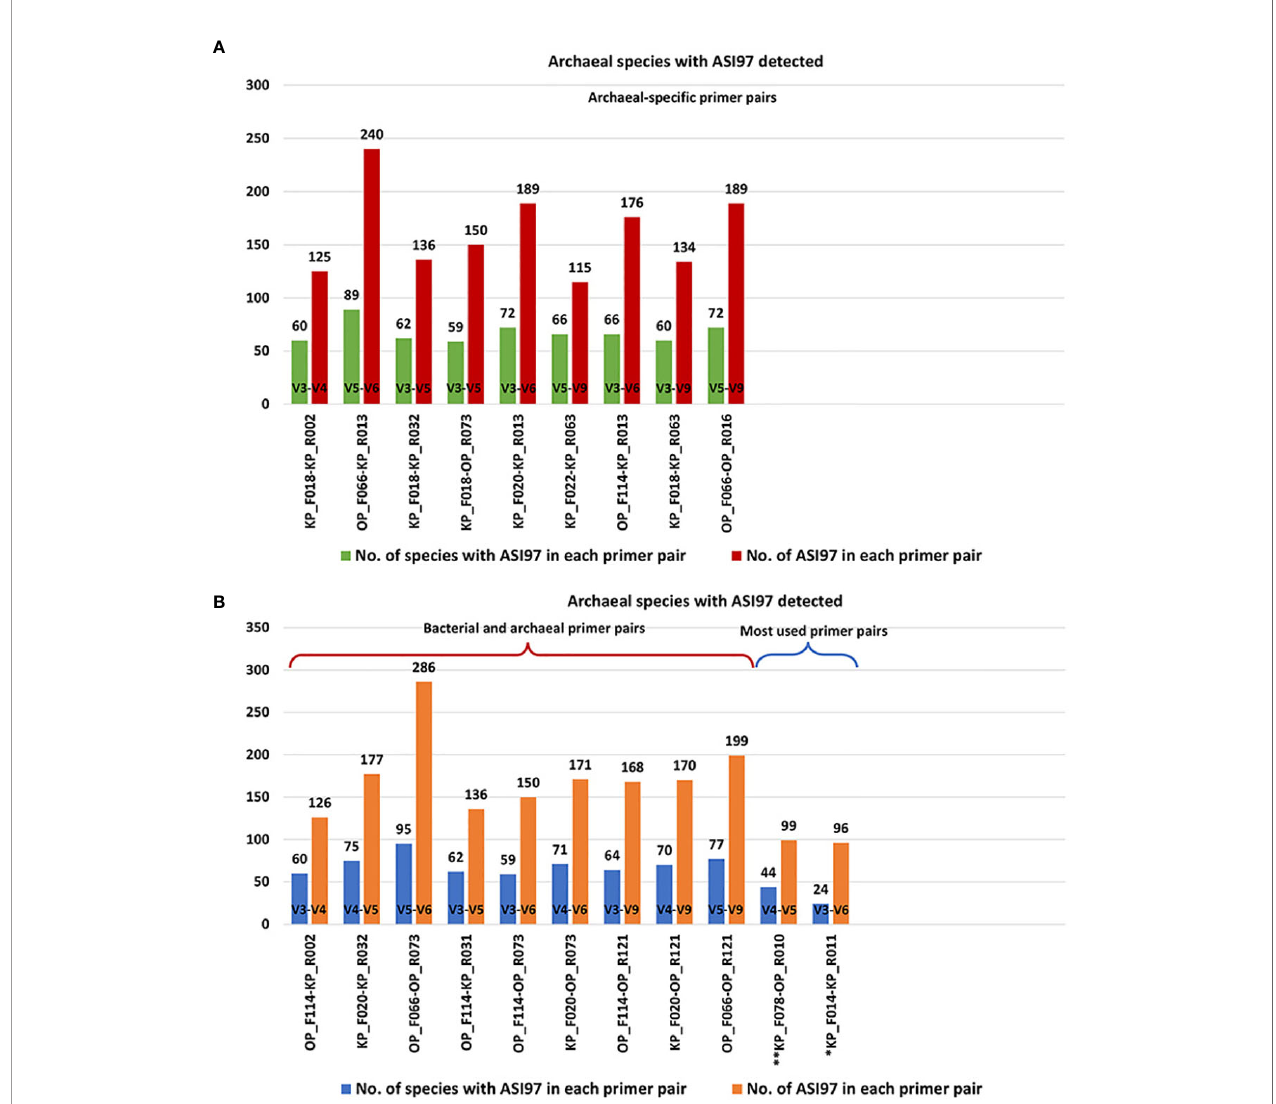
FIGURE 3 | Number of archaeal species with in-silico amplicon similarity values ≥ 97% and number of in-silico amplicon similarity values ≥ 97% with the primer pairs evaluated against the oral archaea genomes. (A) Estimates were obtained by the selected archaeal-speci fi c primer pairs. (B) Estimates were obtained by the selected bacterial and archaeal primer pairs and the primer pairs used the most in the oral microbiome literature. Among the most commonly used primer pairs in the literature, those marked with an * are archaeal-speci fi c and those with ** target both bacterial and archaea. ASI97, in-silico amplicon similarity values ≥ 97%; F, forward; KP, Klindworth primer; No., number; OP, oral primer; R,